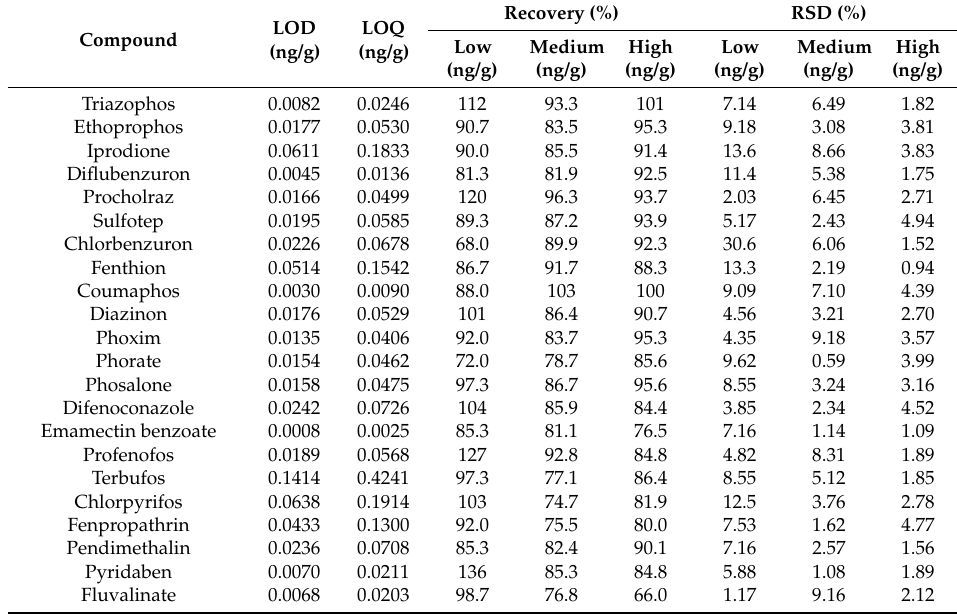
Table 4. Matrix effects (ME), retention time (t R ), linear range, linear regression equation, and linearity. Compound ME (%)